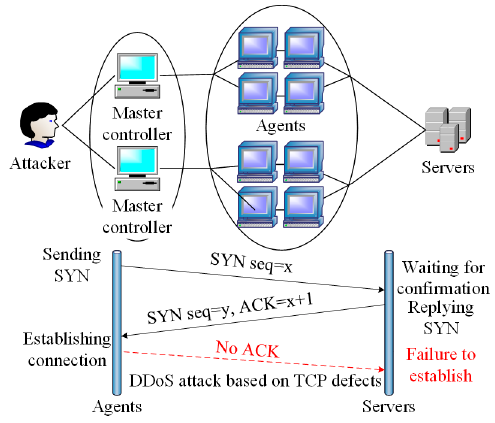
Figure 3. Principles and process of distributed denial-of-service (DDoS) attacks.